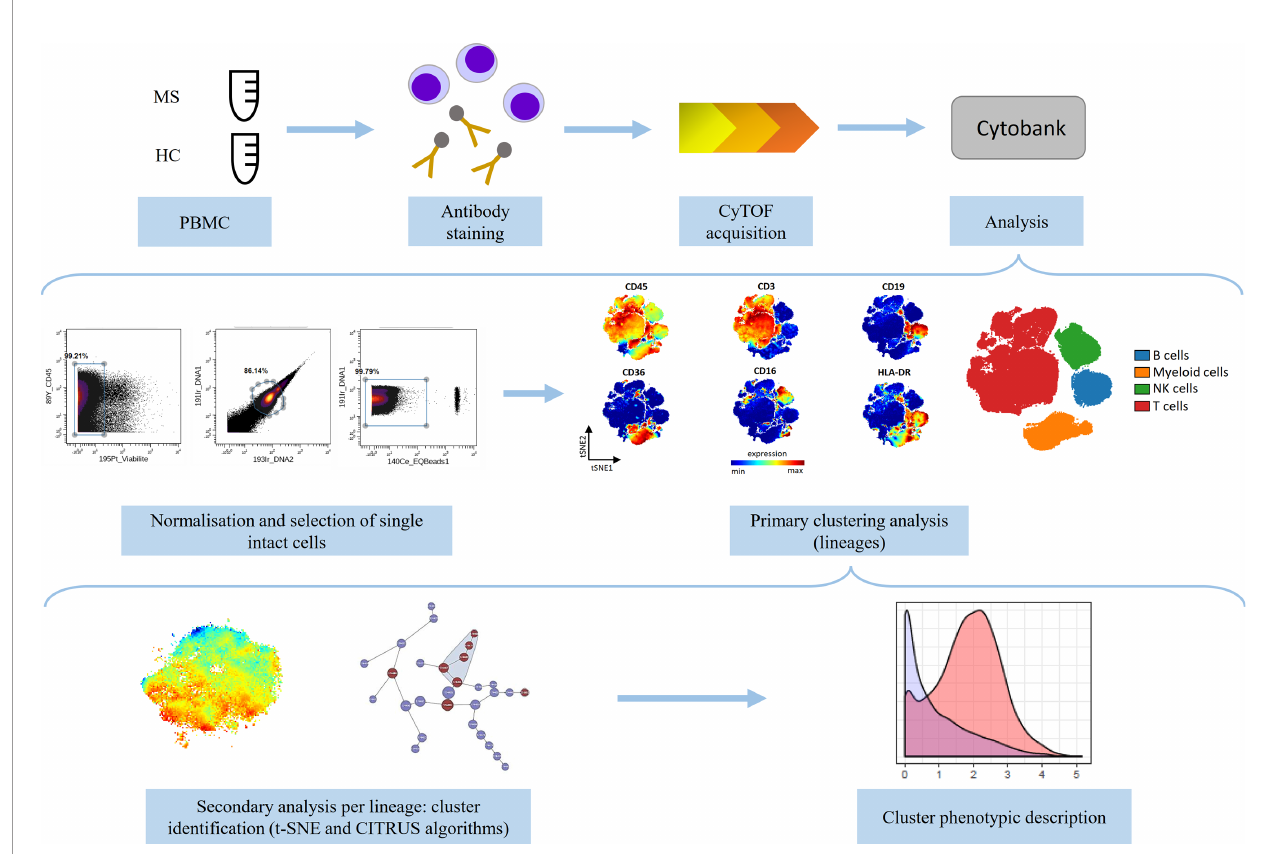
FIGURE 1 | Schematic representation of the experimental design of the study. Peripheral blood mononuclear cells (PBMCs) from multiple sclerosis (MS, n=11) patients and healthy controls (HC, n=8) were divided into two equal parts and stained with two antibody panels (Lymphoid panel and Myeloid panel, Supplementary Tables 1 , 2 ) and acquired on the CyTOF instrument. The data were normalized and single intact cells were manually selected. Primary analysis was performed to identify lineage cell subsets and secondary analysis was performed to describe phenotypic alterations per lineage between MS and HC (using t-SNE and CITRUS algorithms). Phenotypic description of the identi fi ed clusters was